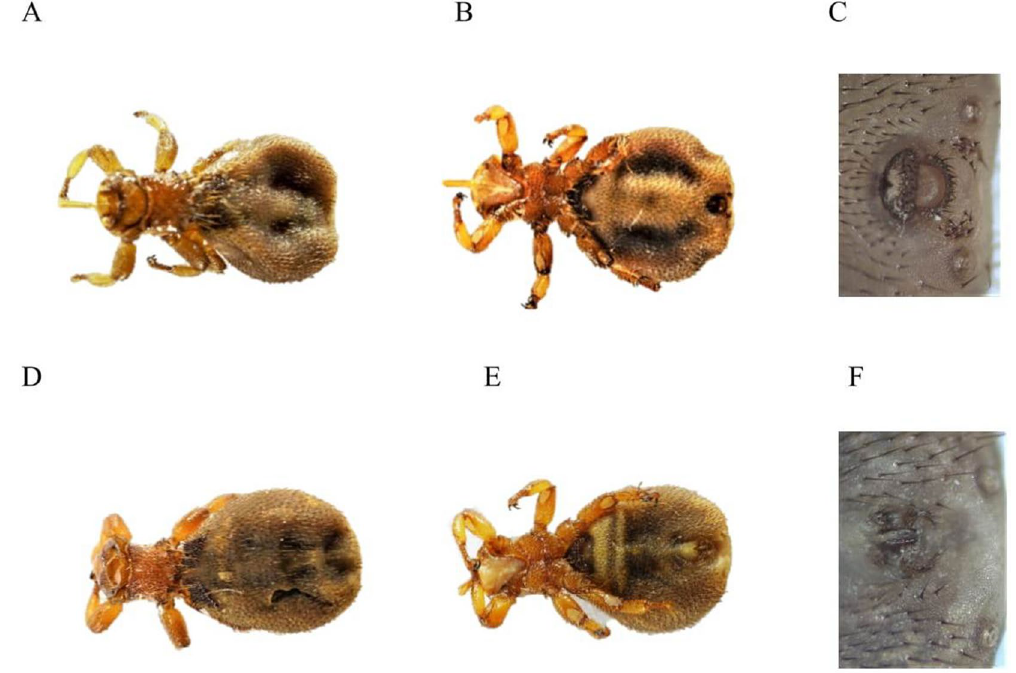
Figure 1. Female of Melophagus ovinus dorsal ( A ) and ventral view ( B ), posterior end ( C ) and male of Melophagus ovinius dorsal ( D ) and ventral view ( E ); Posterior end ( F ).